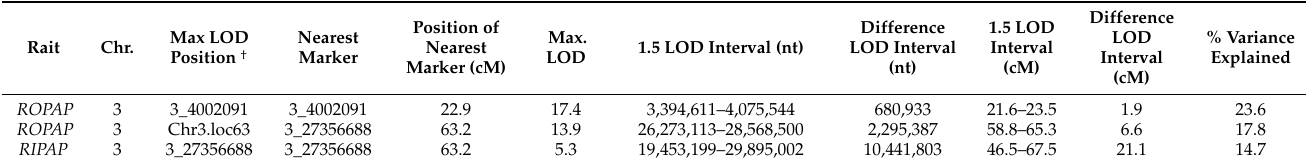
Table 1. Genetic mapping of binary phenotypic traits ‘root outer phloem anthocyanin pigmentation’ ( ROPAP ) and ‘root inner phloem anthocyanin pigmentation’ ( RIPAP ).